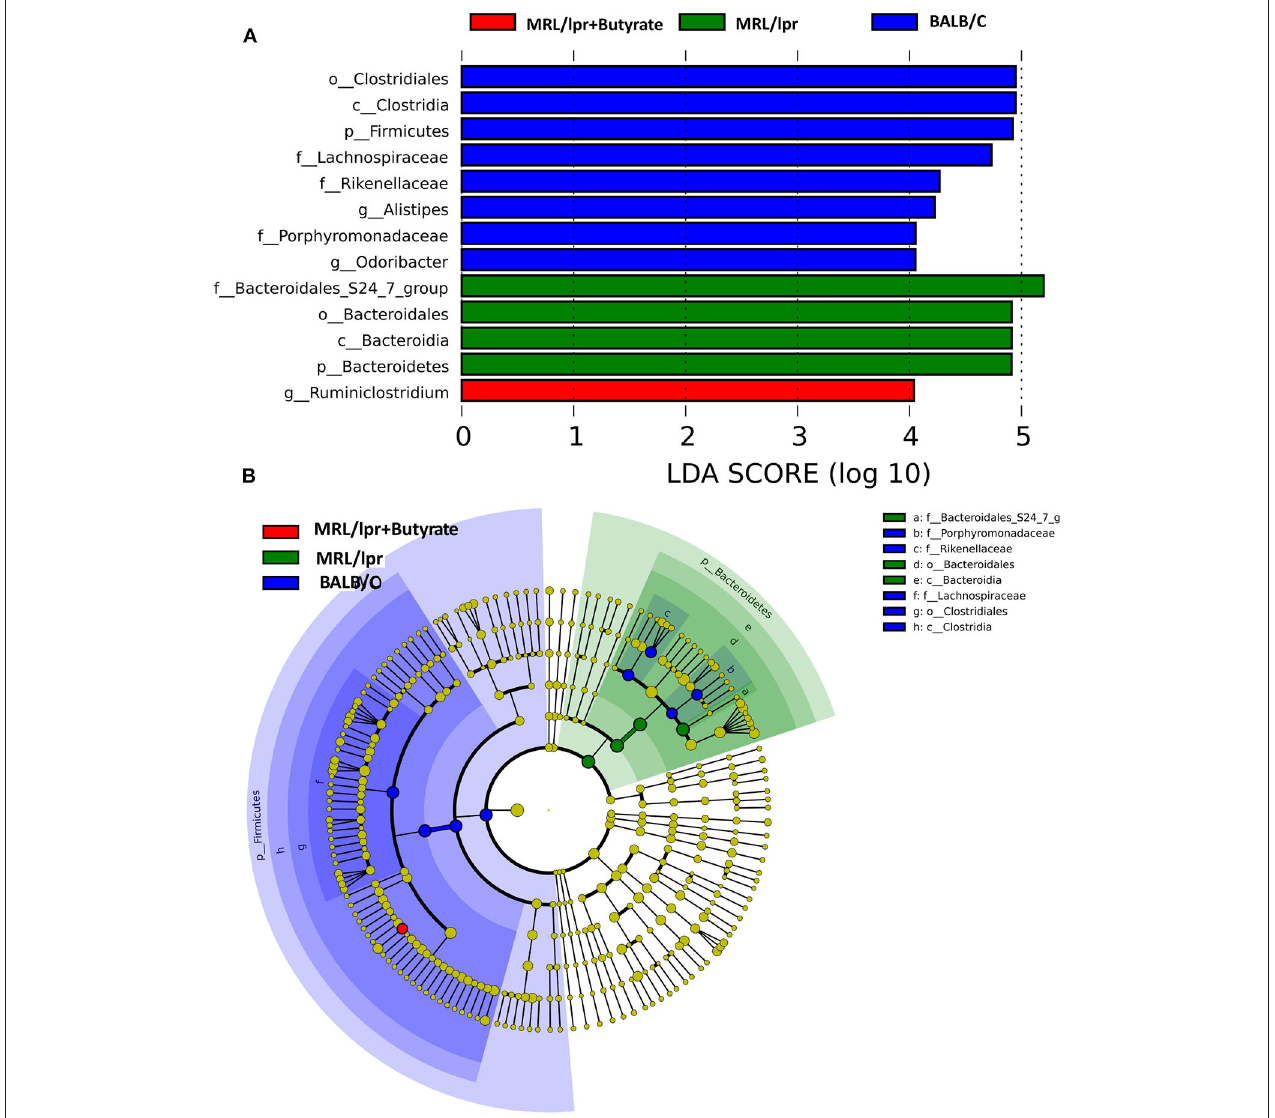
FIGURE 5 | Taxonomic biomarker identification in gut microbiota by linear discriminant analysis (LDA) effect size (LEfSe) and LDA analysis. LEfSe was used to identify differentially abundant taxa (A) , and the LDA score (B) . Significantly distinct taxa among the BALB/c mice (blue), MRL/lpr mice (green), and butyrate-treated MRL/lpr mice